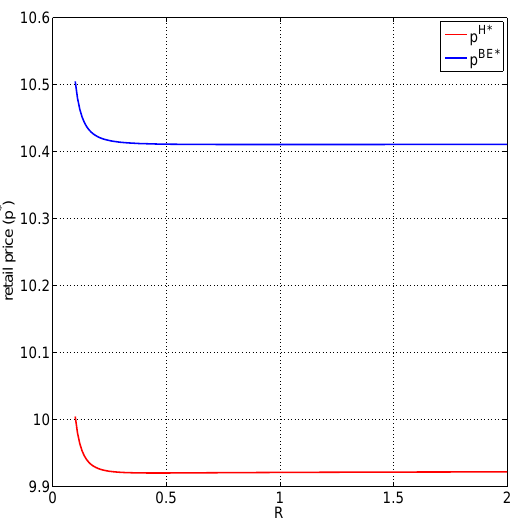
Figure 13. The influences of R on the transfer price b .